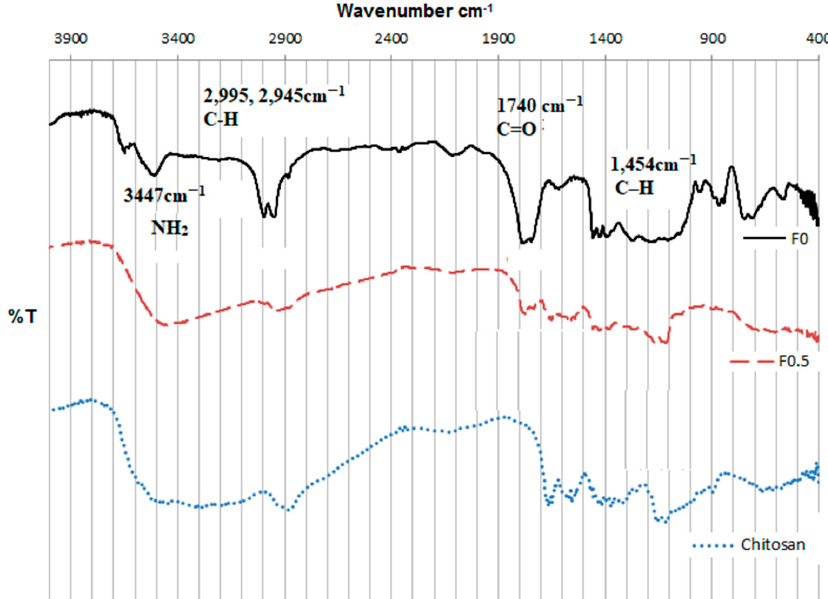
Figure 3. FT-IR spectra of the LMWC raw material, the PLGA NPs (F 0 ), and the LMWC-PLGA NPs (F 0.5 ).